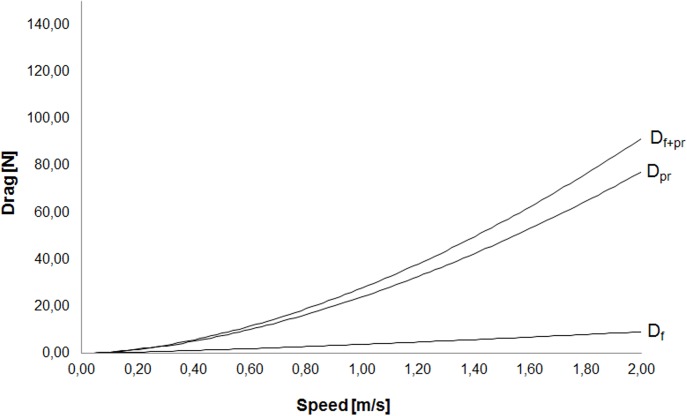
Breakdown of total passive drag (Df+pr, Eq 13) into friction drag (Df, Eq 11) and pressure drag (Dpr, Eq 12) gliding fully immersed.